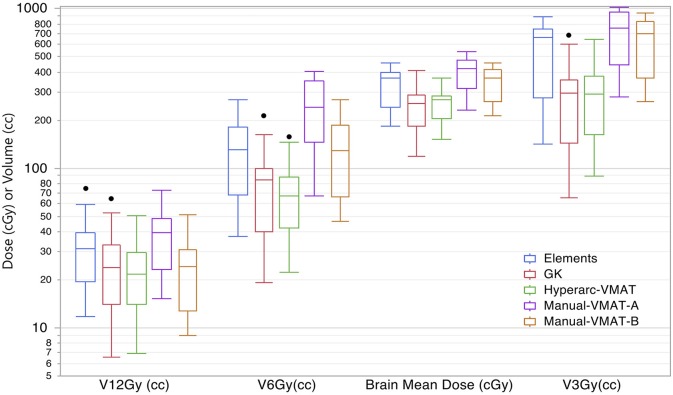
Box plot results per SRS plan type for the following dosimetric parameters across all patients: the total volume of brain receiving 12Gy, 6Gy, and 3Gy (V12Gy, V6Gy, V3Gy) and the mean dose to the brain excluding the targets (Brain mean dose).